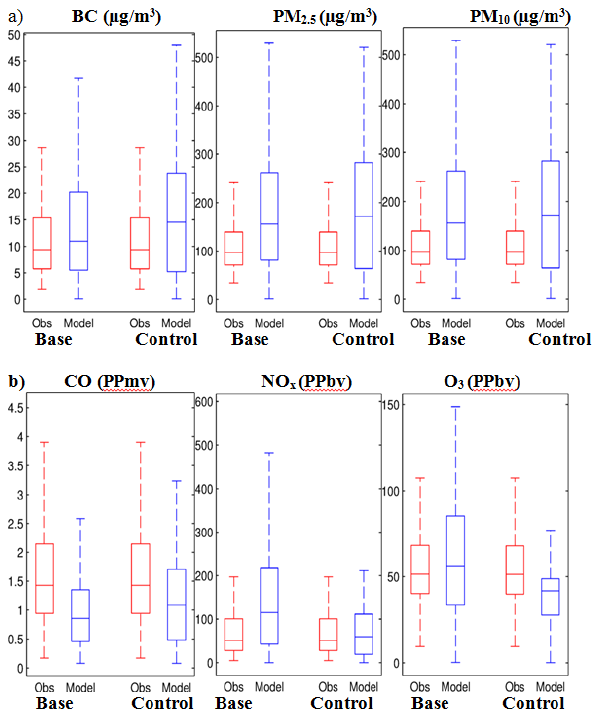
Figure 6. Comparison of the distributions of observed and modeled hourly concentrations using data from all sites. Base corresponds to full emissions whereas control shows results where the NO x emis- sions were reduced by a factor of 3.